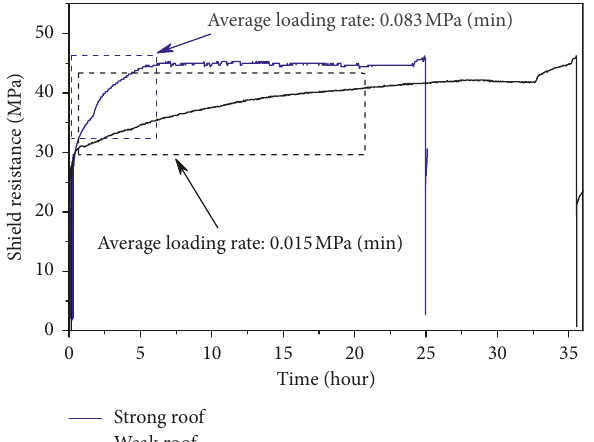
Figure 7: Temporal evolution of shield resistance during a typical shield-supporting cycle under strong roof and medium-weak roof.